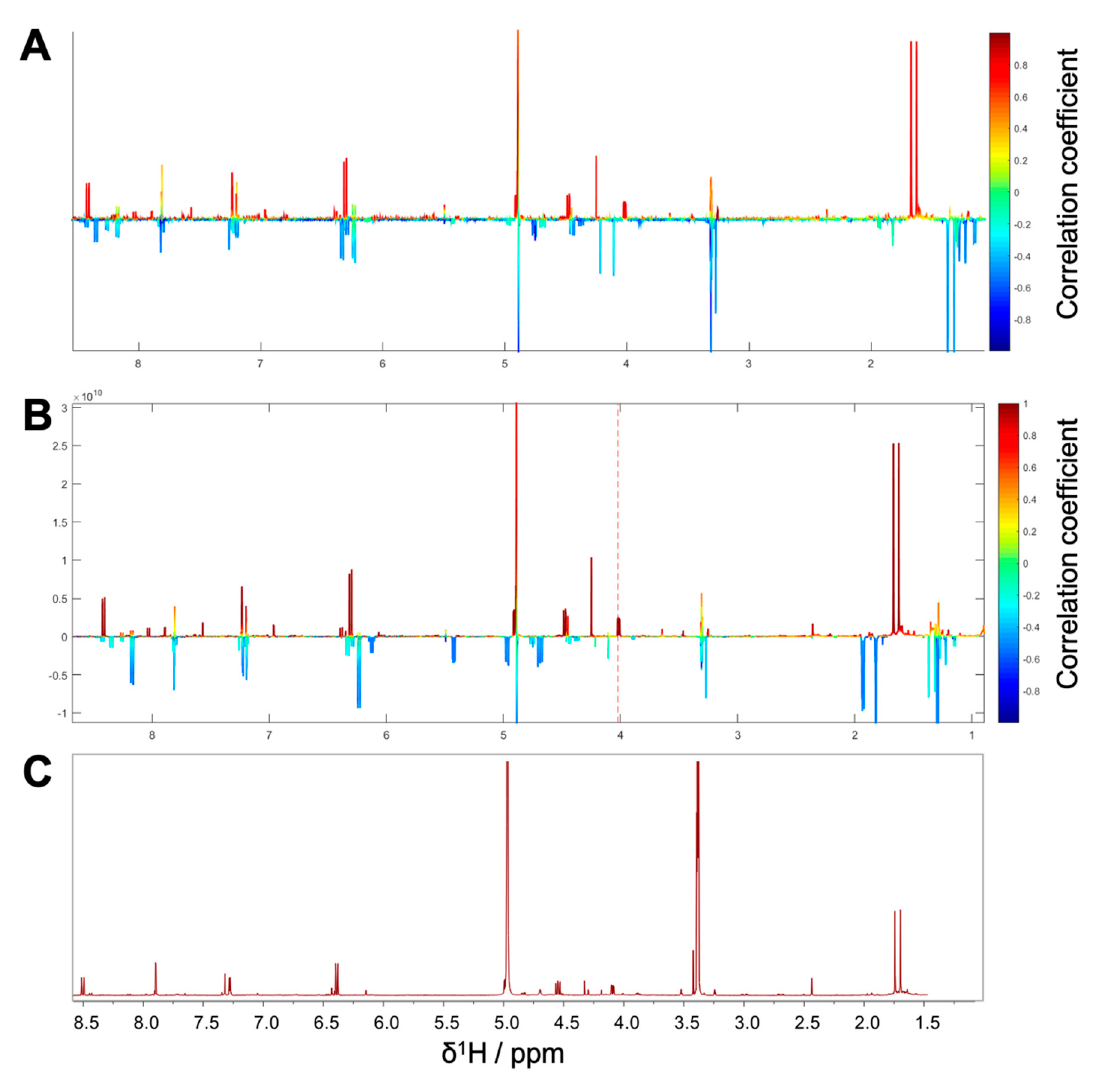
Figure 5. Package III ( A ) HetCA plot of PO01_22–PO01_25. ( B ) STOCSY plot; the signal at δ H 4.03 was chosen to obtain the information which molecule(s) share this hot feature and ( C ) 1 H NMR spectra of the isolated active compound 4 .